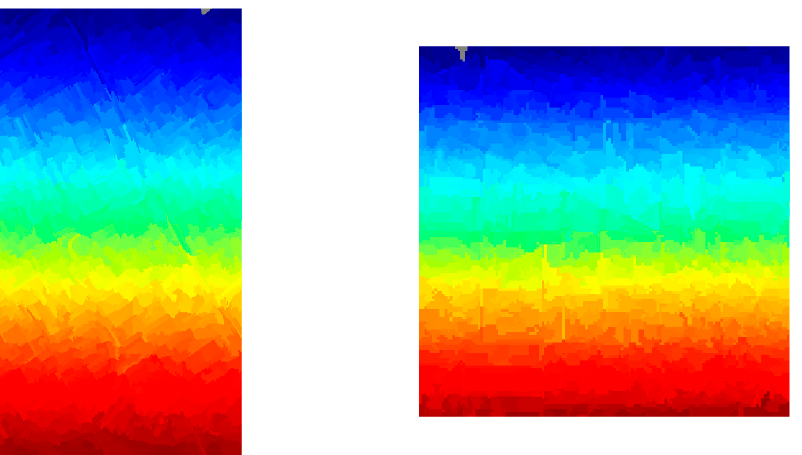
Figure 5. Pseudo-color plot of the dataset after superpixel segmentation of 1000 blocks. PaviaU dataset on the left, Indian Pines dataset on the right.